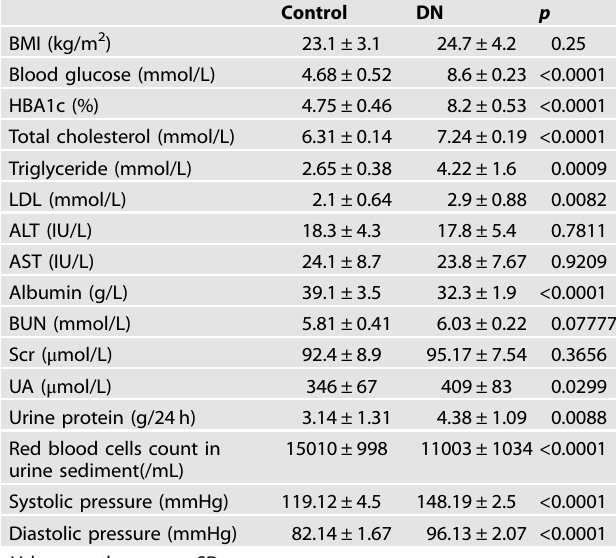
Table 1. Clinical characteristics of the patients with DN and the patients with minor lesions who did not have